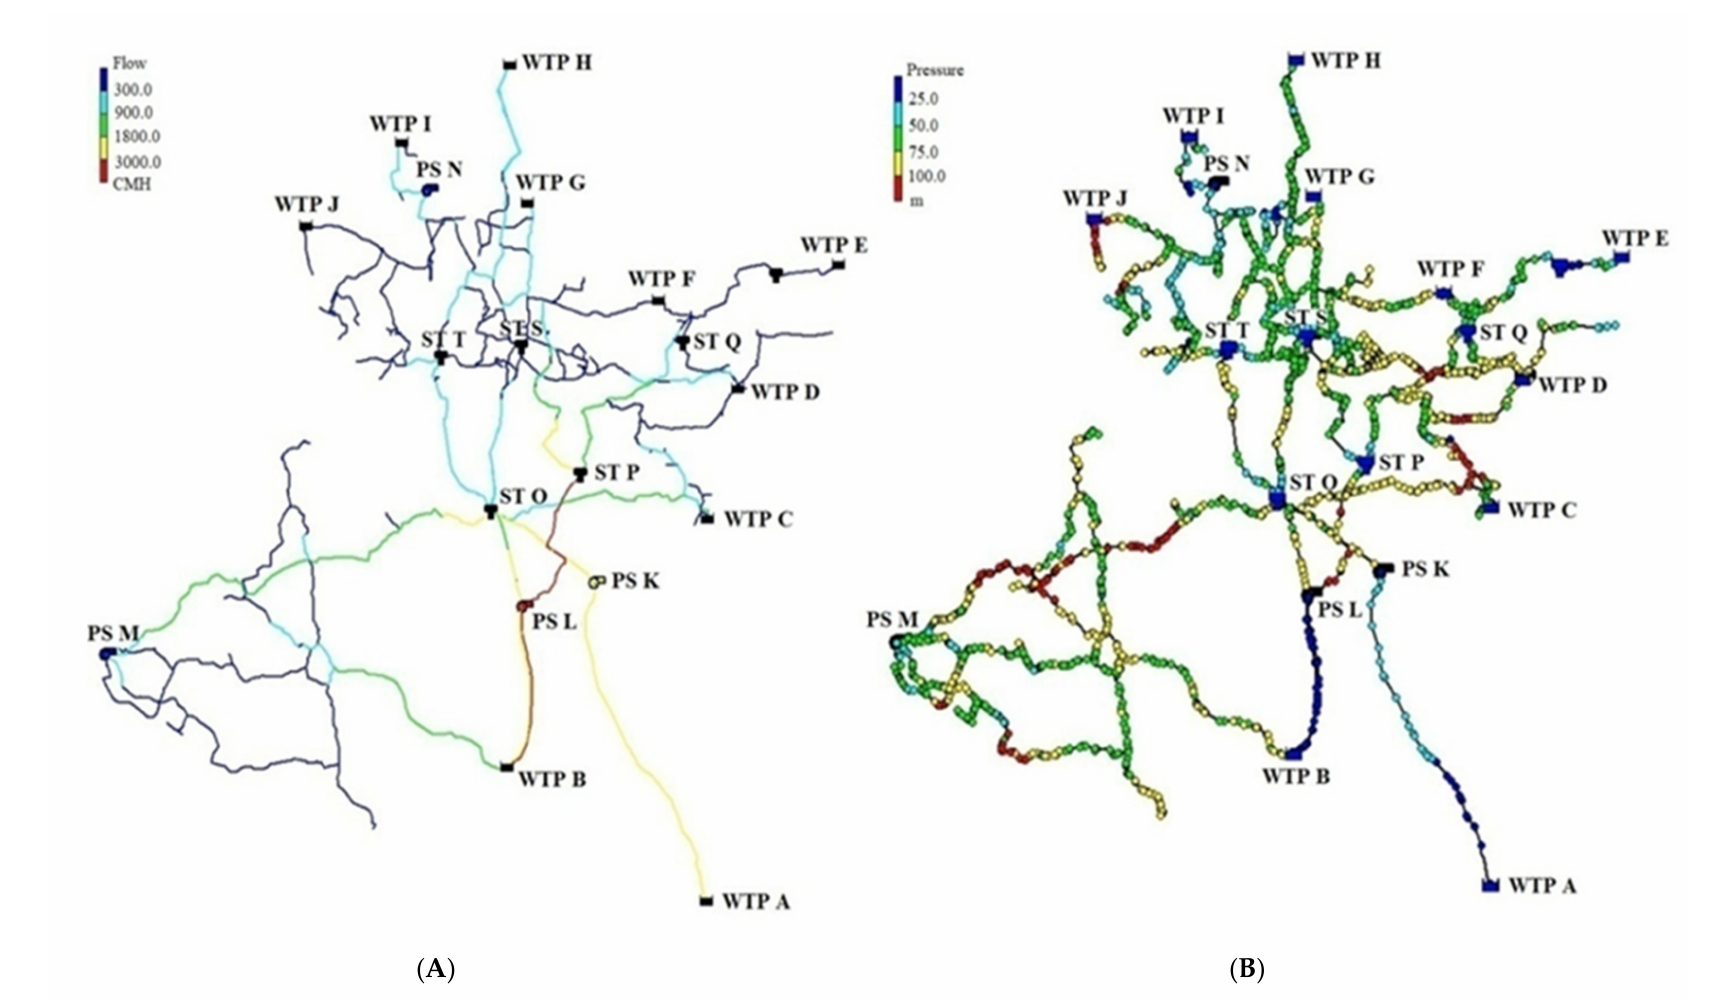
Figure 3. WSS scheme with ( A ) average water flows and ( B ) average